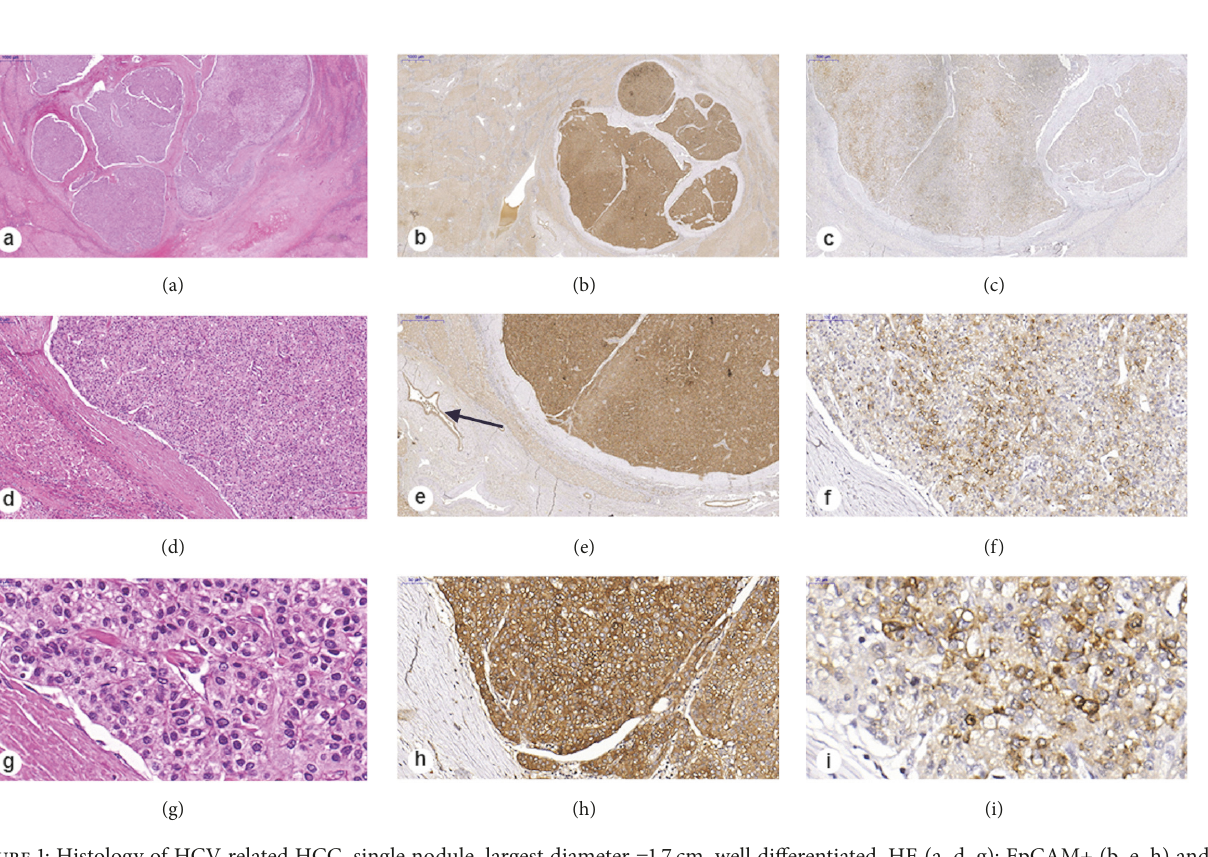
Figure 1: Histology of HCV-related HCC, single nodule, largest diameter =1.7cm, well differentiated. HE (a, d, g); EpCAM+ (b, e, h) and AFP+ (c, f, i). Internal positive control for EpCAM is observed in the bile duct (arrow). Blue bars show increase in